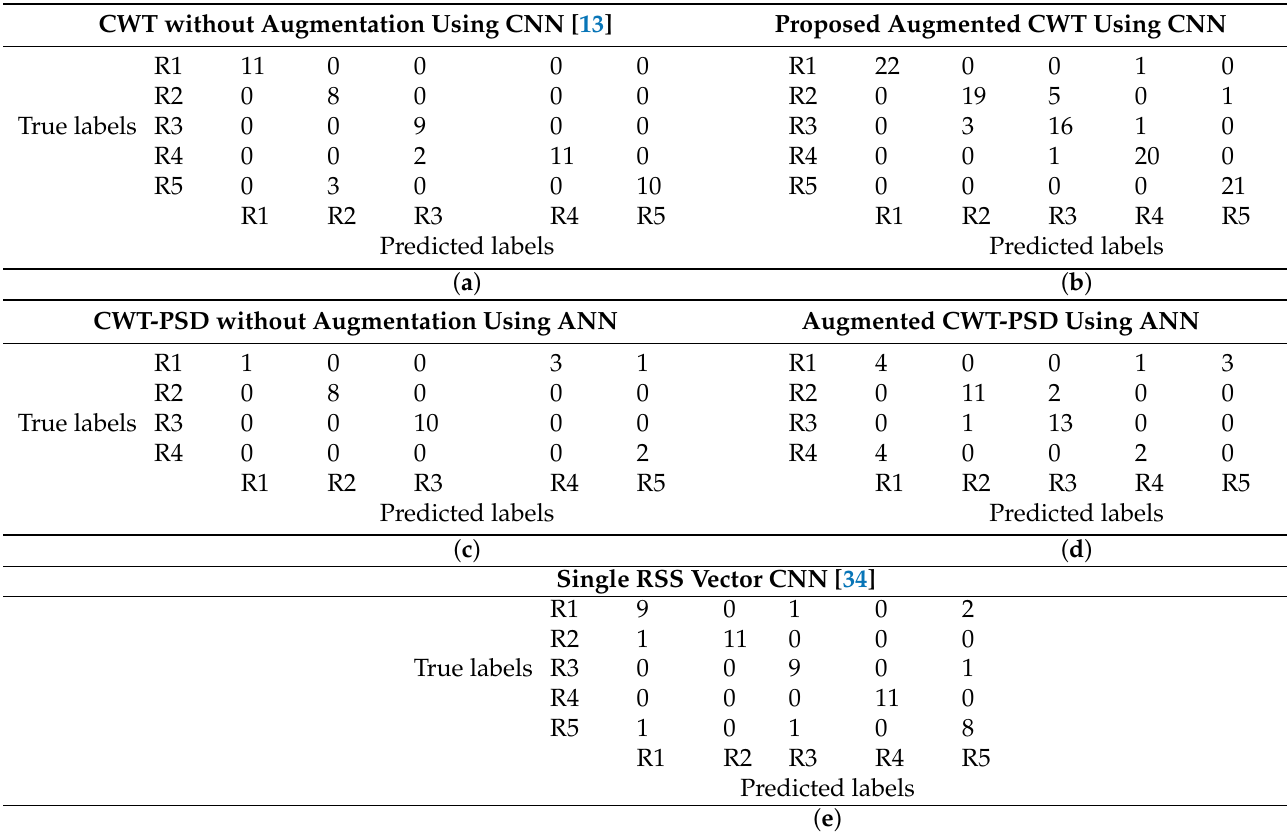
Table 7. Confusion matrices for room identification using the Morlet mother wavelet. CWT without Augmentation Using CNN [13] Proposed Augmented CWT Using CNN